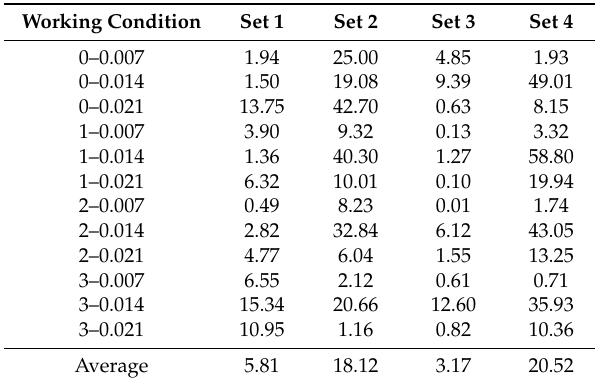
Figure 5a,b transforms Tables 3 and 4 in graphic ways, respectively.